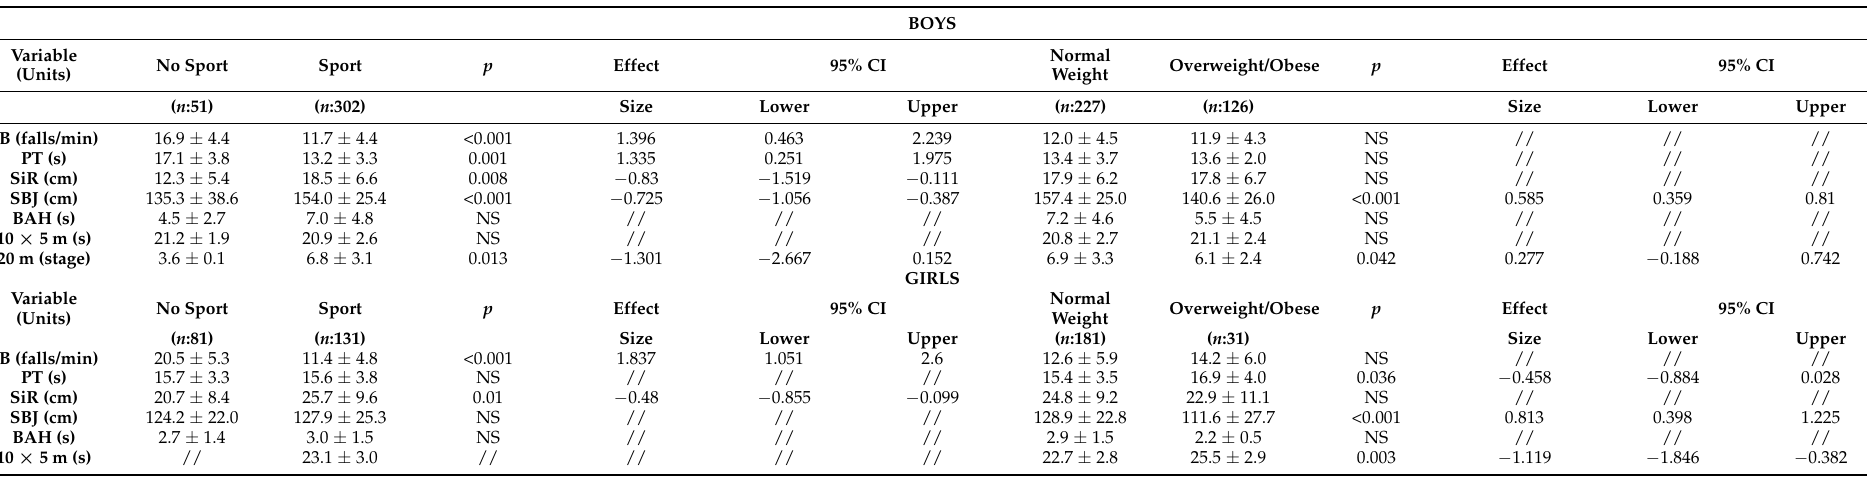
Table 2. Physical fitness scores of children stratified by sex (boys and girls), sport (no sport/sport) and weight status (normal weight and overweight/obese).